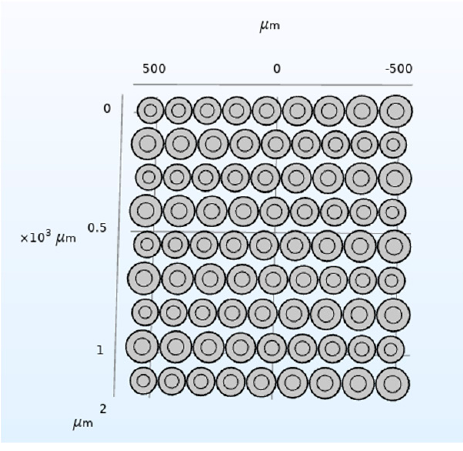
Figure 16. CMUT structure ( w = 50%).